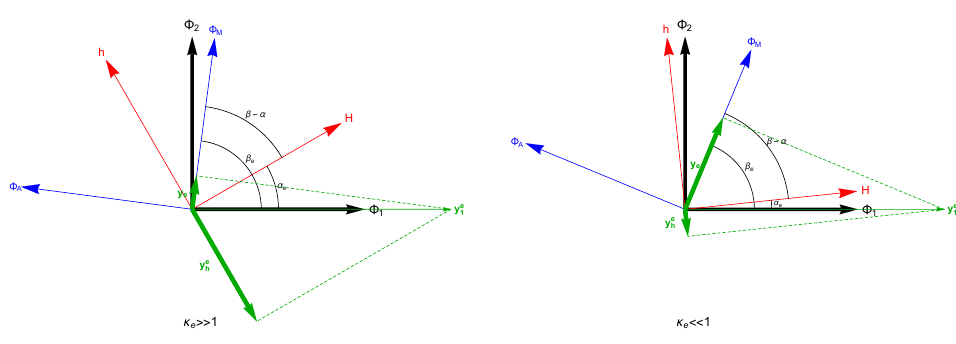
Figure 1 . Geometric representation of the three bases, ((cid:8) 1 ; (cid:8) 2 ) (black), ((cid:8) M ; (cid:8) A ) (blue),